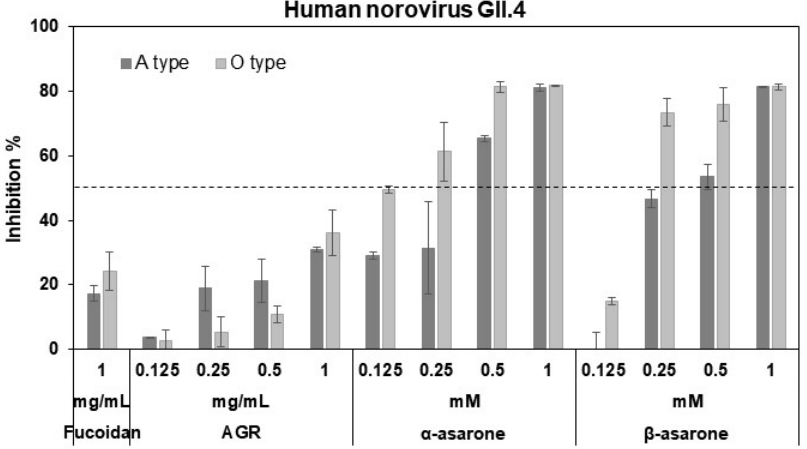
Figure 2. Inhibition of binding of the HuNV GII.4 P domain to saliva by AGR extract, α -asarone, and β -asarone. Inhibition was analyzed by ELISA assay. A positive control was a commercial fu- coidan and the dashed line designates 50% inhibition. and the dashed line designates 50%